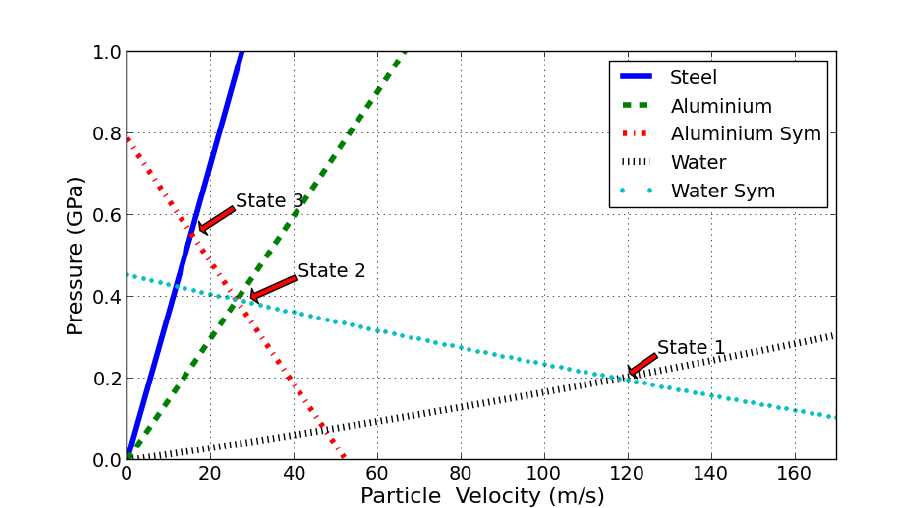
Figure 5. P-u diagram showing the successive states of water, aluminium, and steel under a 200 MPa incident shock load. The shock comes from the water, is transmitted into the aluminium and then into the